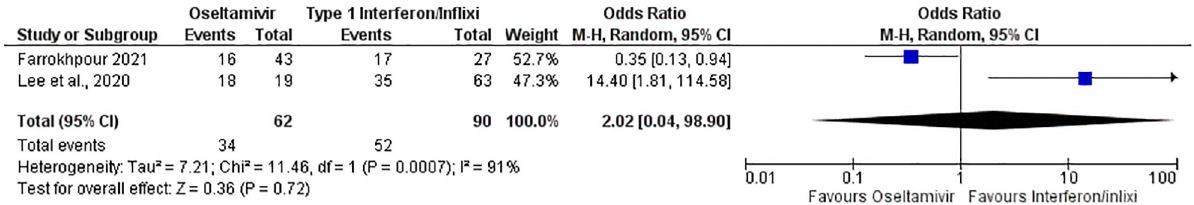
PLOS ONE | https://doi.org/10.1371/journal.pone.0277206 December1, 2022 10 /